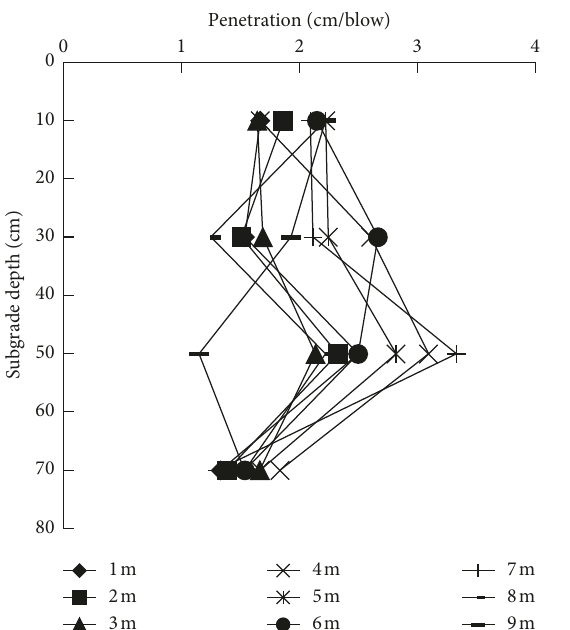
Figure 4: Relationship between penetration and silt subgrade depth.